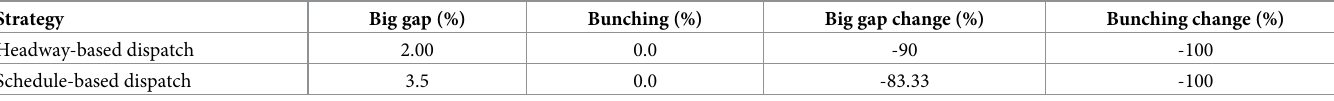
Table 12. Effect of terminal dispatch strategies on big gap and